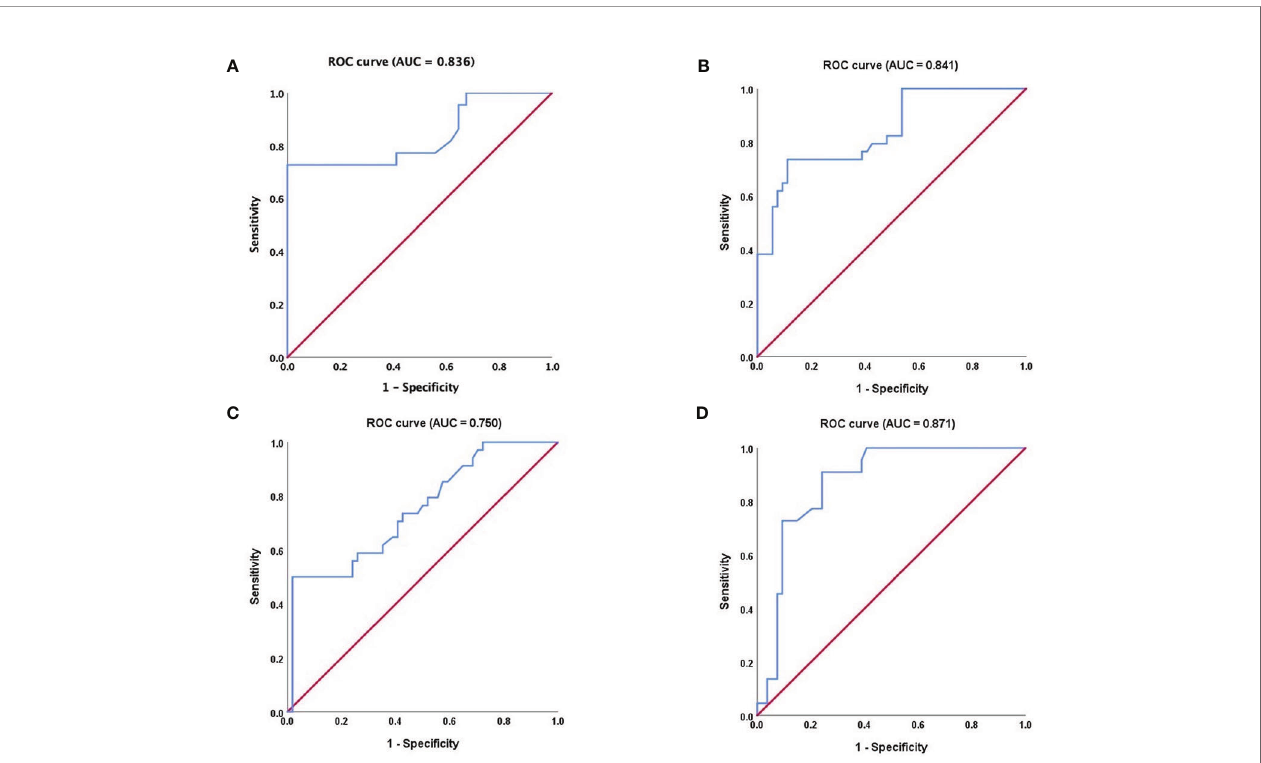
FIGURE 6 | Receiver operating characteristic (ROC) curve analysis. (A) regarding RS, ROC curve for WT and BCA tumors (P < 0.001, AUC = 0.836); (B) regarding MTT, ROC curve for WT and PA tumors (P < 0.001 and AUC = 0.841); (C) regarding HT, ROC curve for WT and PA tumors (P < 0.001 and AUC = 0.750, respectively); (D) regarding PI; ROC curve for PA and BCA tumors (P < 0.001 and AUC = 0.871). ROC, receiver operating characteristic; AUC, area under the curve; RS, rising slope; MTT, mean transit time; HT, time from peak to one half, PI, peak intensity. The nonparametric estimate of the AUC and its 95% con fi dence interval are shown respectively. The non-parametric estimate of AUC is the sum of the areas of the trapezoids formed by connecting the points on the ROC curve. Please refer to the Supplementary Materials for